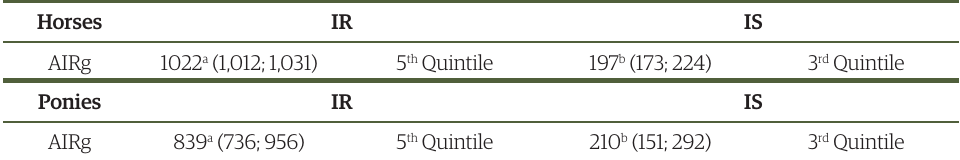
Table 2. Acute insulin response to glucose (AIRg, mu.l^-1.min) values, and respective quintiles, for horses and ponies.